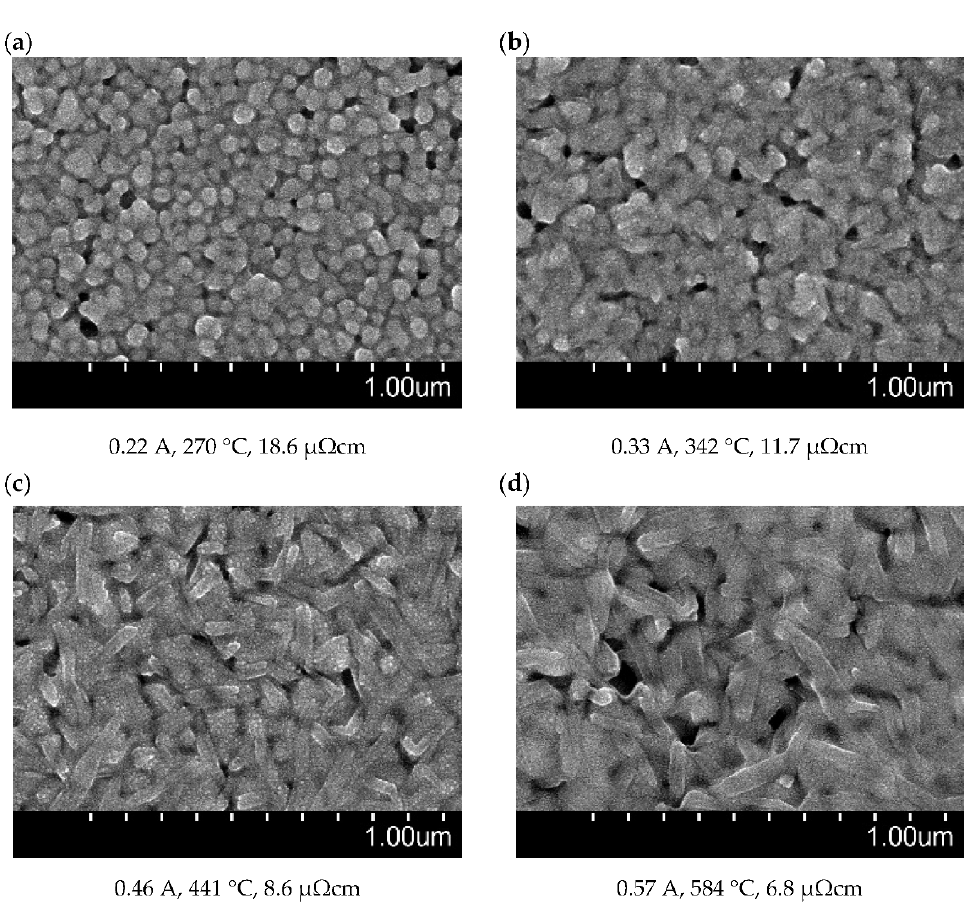
Figure 7. SEM micrographs of the sintered conductive ink lines via the SCIS technique.